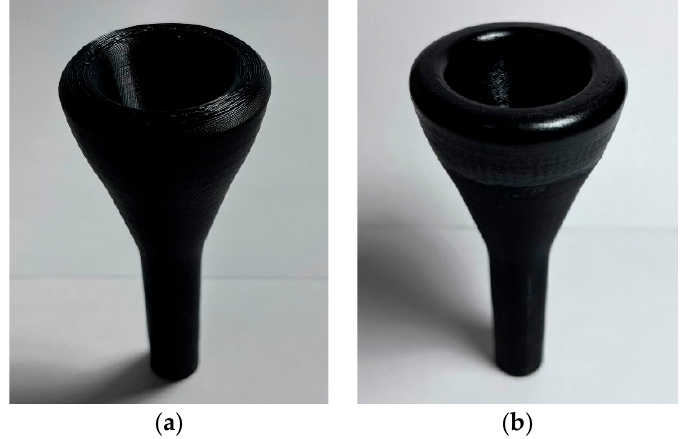
Figure 4. 3D Printed mouthpiece: ( a ) just after printing; ( b ) finished mouthpiece after manual sanding of the rim.